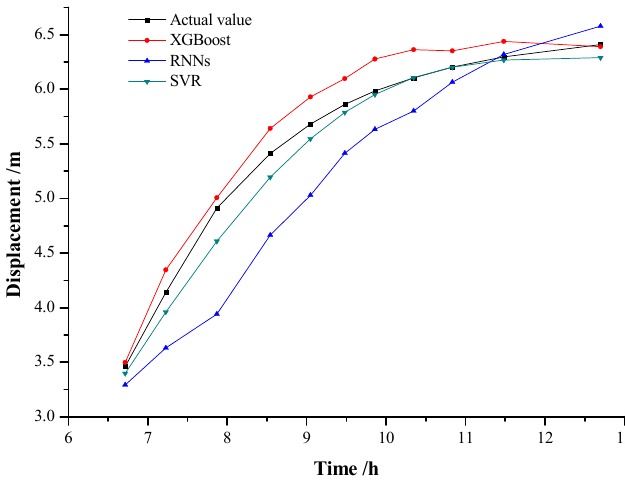
Figure 7. Variation of displacement predicted values of D7 with time.